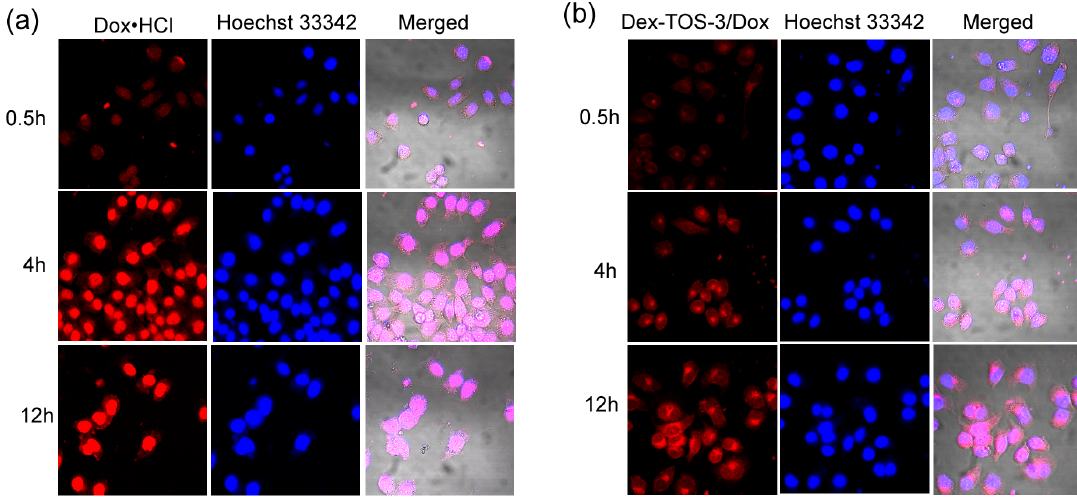
Figure 7. Confocal laser scanning microscopy (CLSM) images of human nasopharyngeal epidermoid carcinoma (KB) cells after incubation with ( a ) doxorubicin hydrochloride (Dox·HCl) and ( b ) Dex-TOS-3/Dox micelles for 0.5, 4 and 12